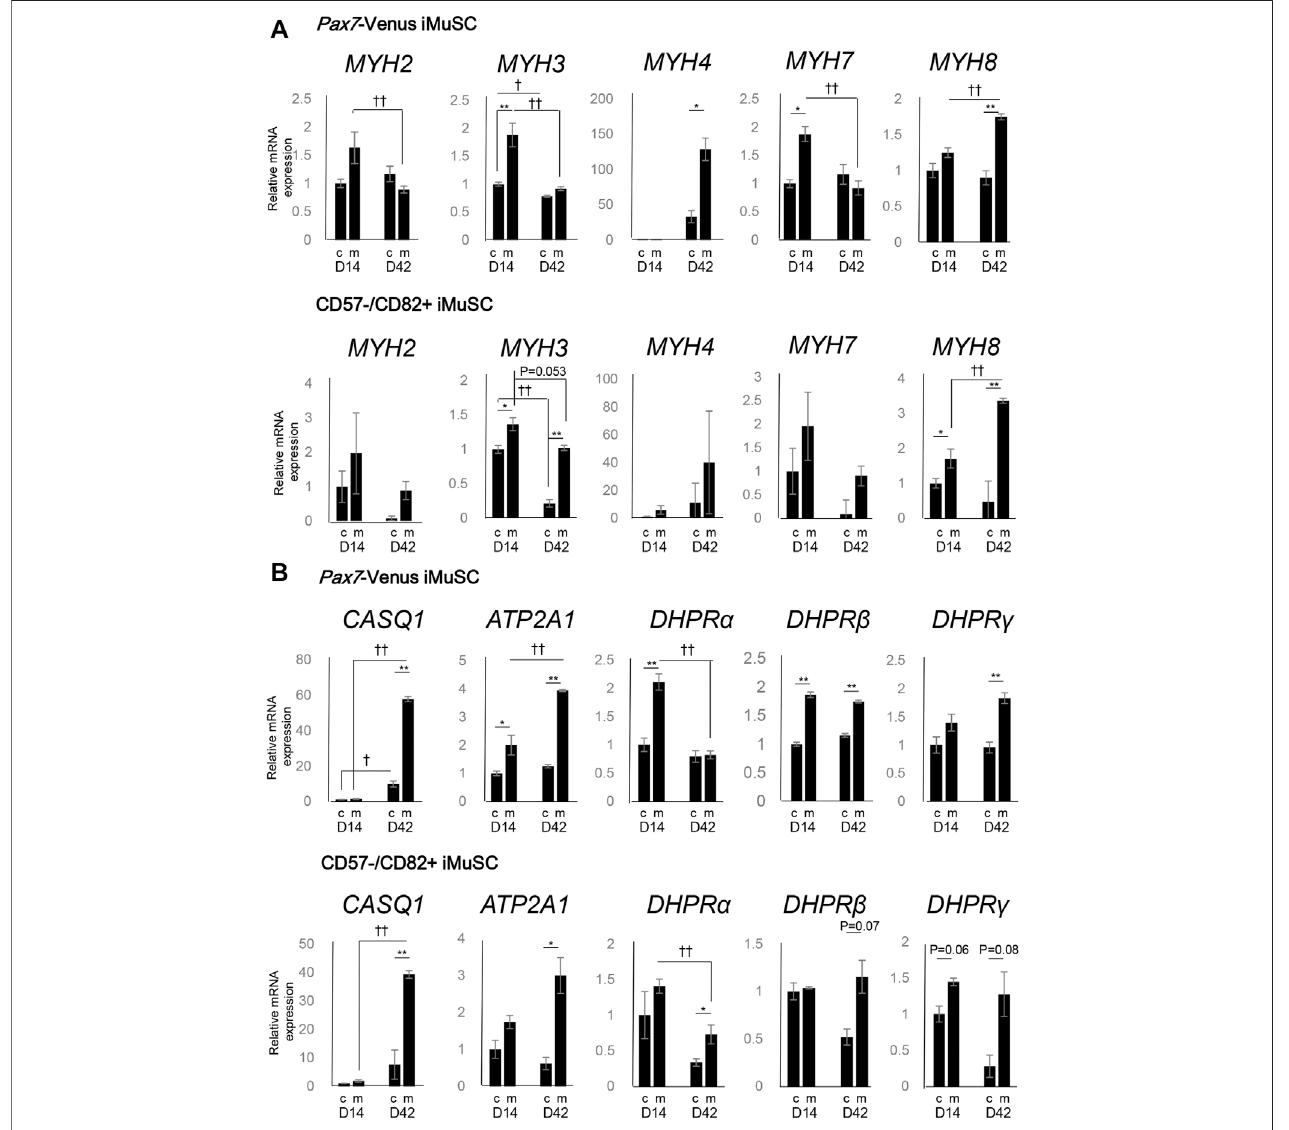
FIGURE 2 | Myosin heavy chain (MYH) subtypes and triad-associated genes display characteristic expression patterns. (A) The mRNA expression of the myosin heavy chain family (MYH2, MYH3, MYH4, MYH7, and MYH8) was quanti fi ed by real-time PCR. The expression levels of the MYH genes in PAX7-Venus iMuSC-derived myotubes (upper) and in CD57 − – CD82 + iMuSC-derived myotubes (lower) on days 14 and 42 in c-condition (no Matrigel embedding) and m-condition (Matrigel embedding) are shown. (B) The mRNA expression of SR-related genes (Casq1 and Atp2a1) and t-tubule-related genes (DHPR α , DHPR β , and DHPR γ ) was quanti fi ed by real-time PCR. The expression levels of MYH genes in PAX7-Venus iMuSC-derived myotubes (upper) and in CD57 − – CD82 + iMuSC-derived myotubes (lower) on days 14 and 42 in c-condition and m-condition are shown. The vertical axis of the graph shows the relative expression level normalized by 18S rRNA, the housekeepinggene.Theexpressionlevelisstandardizedbytheexpressionlevel(=1)onday5.* p < 0.05,** p < 0.01;c-condition vs.m-condition. † p < 0.05, †† p <